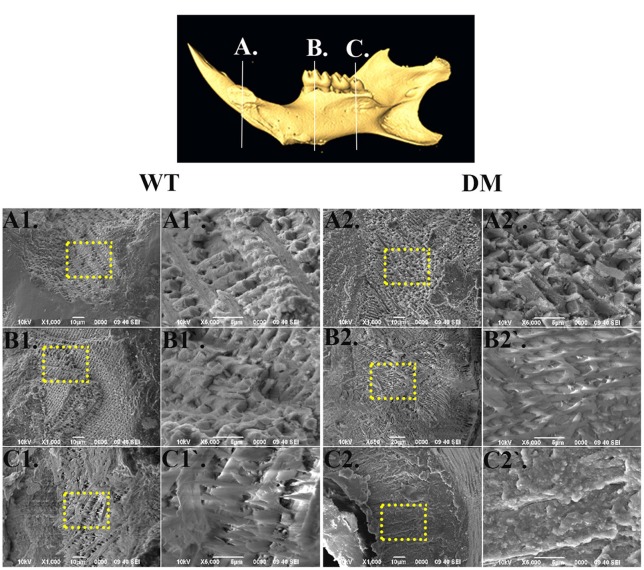
SEM analysis of enamel microstructures in wild-type and double-mutant mandibular incisors. WT, Wild-type; DT, Double-mutant. (A1–C1) Wild-type enamel at reference planes A, B, and C under 1000x magnification. (A1'–C1') The areas in (A1–B1) labeled with dotted frames under 5000x magnification. (A2–C2) Double-mutant enamel at the reference planes A, B, and C under 1000x magnification. (A2'–C2') The areas in (A2–B2) labeled with dotted frames under 5000x magnification. At the first and the second reference planes, wild-type enamel showed typical microstructure of maturation-stage enamel with rods and interrods laid out in a decussating and orderly pattern (A1,A1',B1,B1). In wild-type enamel at secretory stage, marked by the third reference plane, enamel rods did not reach full thickness and the boundary between rod and interrod structure was not yet well defined (C1,C1). In comparison, the structure of double-mutant enamel at the first and the second reference planes was similar to that observed at the second and the third reference planes, respectively, in the wild-type group (A2,A2,B2,B2). There was a complete lack of decussating pattern in double-mutant enamel in the region labeled by the third reference plane, and aprismatic enamel/enamel-like structure dominated the whole vision field (C2,C2).